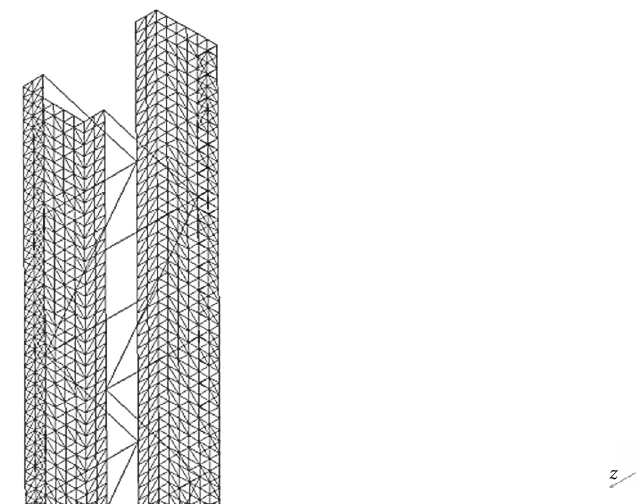
Fig. 6. The mode of the flexural buckling shape of the steel built-up column about axis z-z